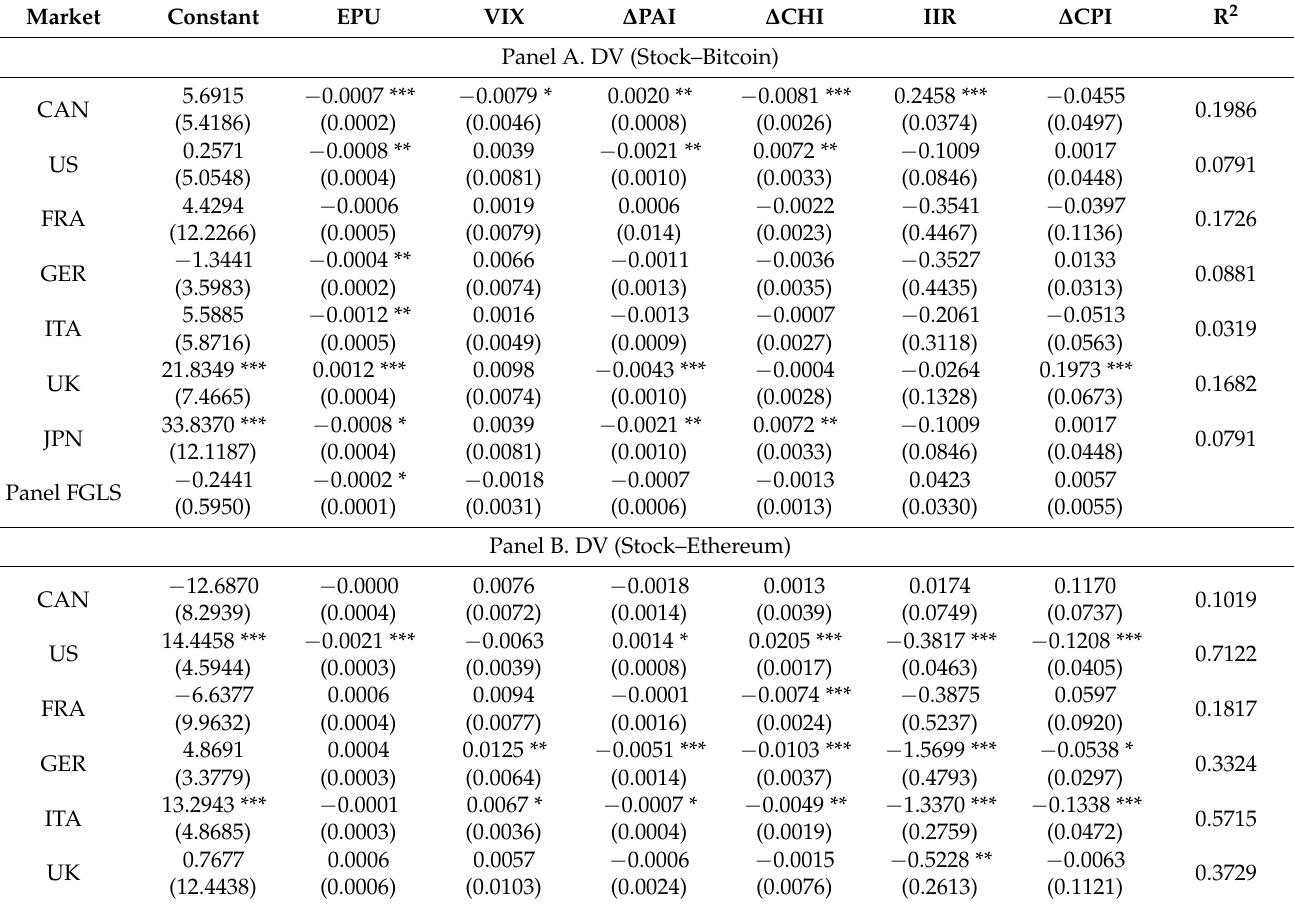
Table A1. SUR Estimation on Short Run Stock-Cryptocurrency Comovements.